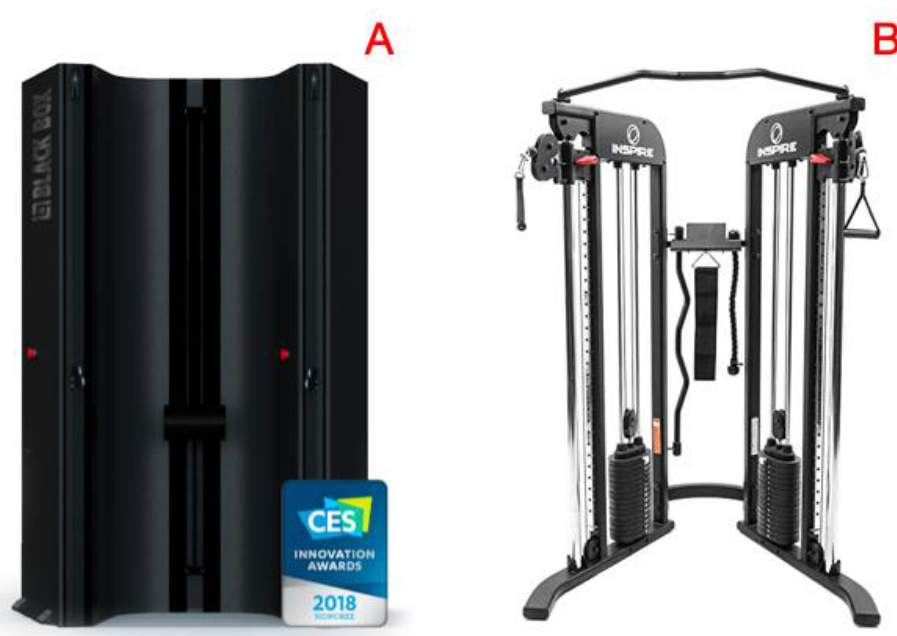
Figure 2. Blackbox VR ® servo-based system used by IVR ( A ) compared to conventional cable/pulley- based crossover machine using dual-selectorized weights ( B ) used by SELF.